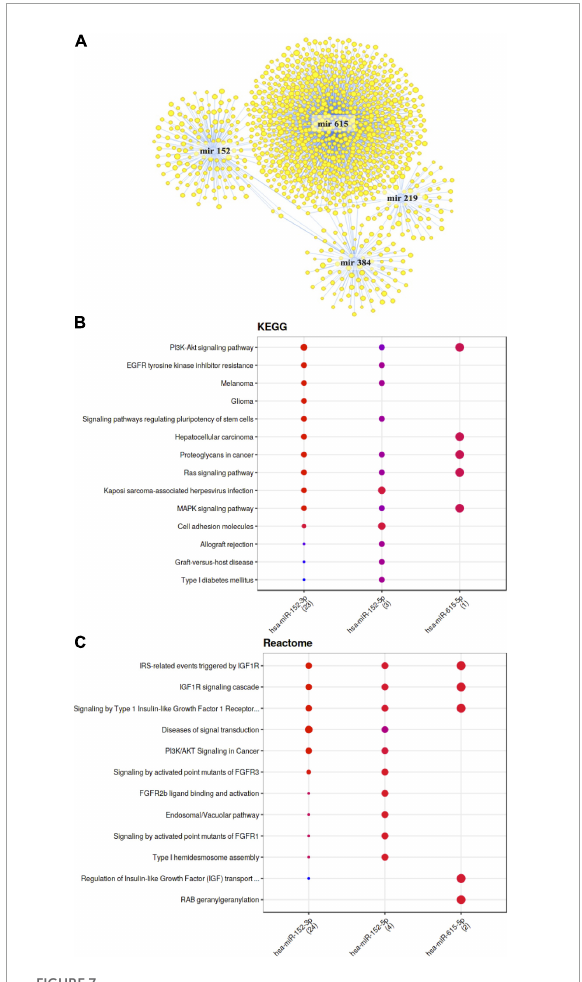
FIGURE7 Bioinformatic analyses of differentially expressed miRNA and their target mRNA. (A) Network of miRNA significantly modulated with consumption of anthocyanin-rich black beans extract and their target mRNA. (B) KEGG pathways associated with miRNA modulated with consumption of anthocyanin-rich black beans extract. (C) Reactome pathways associated with miRNA modulated with consumption of anthocyanin-rich black beans